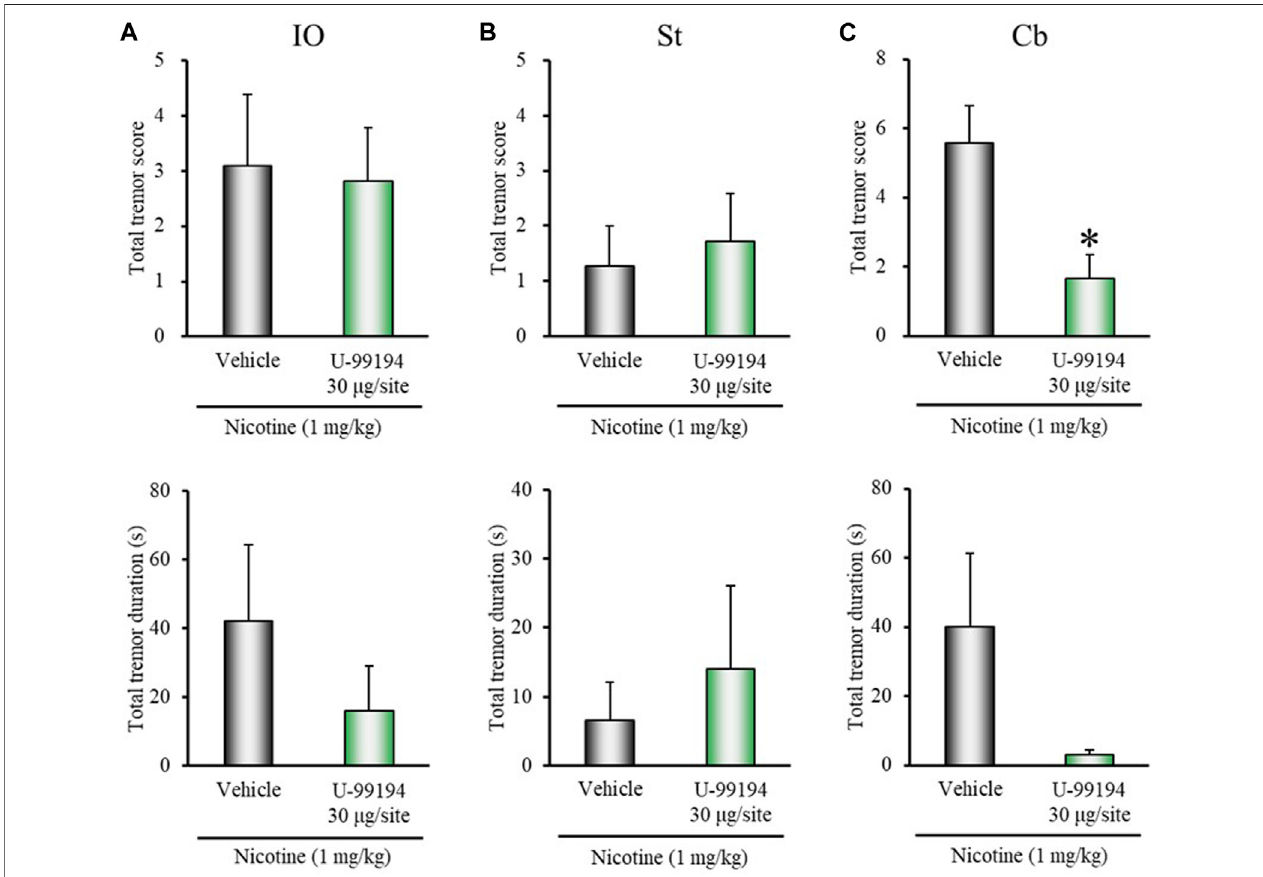
FIGURE 5 | Effects of brain microinjection of U-99194 on nicotine-induced tremor in rats. The D 3 antagonist U-99194 (30 μ g/injection site) or vehicle (control) was injected into: (A) IO, (B) the striatum (St), or (C) the cerebellum lobe IX (Cb) in rats 15 min before the nicotine (1 mg/kg, i.p.) injection. Data show the total tremor score (intensity) and duration of nicotine-induced tremor during the 5 – 16 min observation period. Each column represents the mean ± S.E.M. * p < 0.05: Signi fi cantly different from control animals.